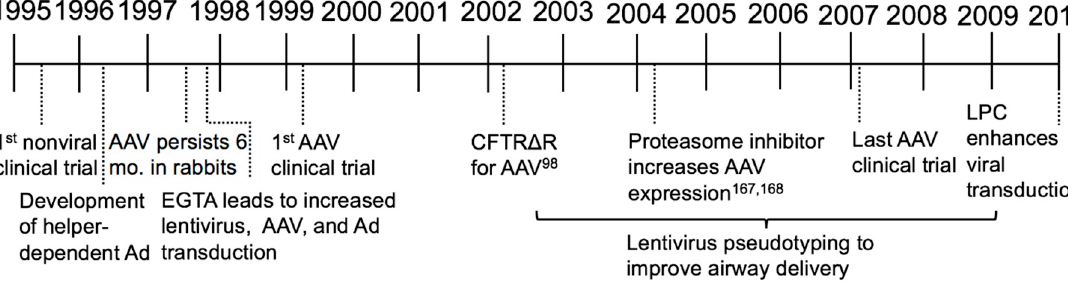
Figure 3. Important milestones for the second era of CF gene therapy (1995–2010).